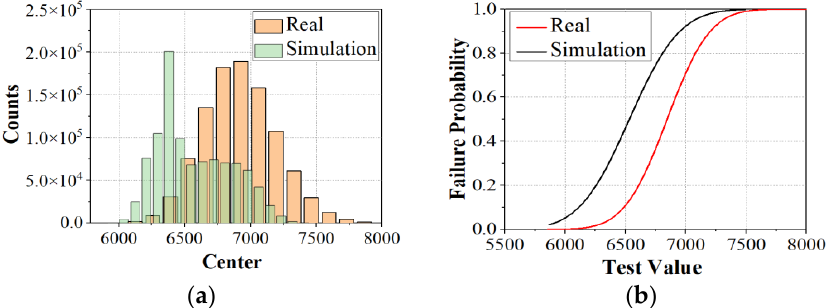
Figure 1. This is distributions of the random variables 𝑇 (real) and 𝑇̃ (simulation). ( a ) Distribution histogram ( b ) Cumulative distribution function.